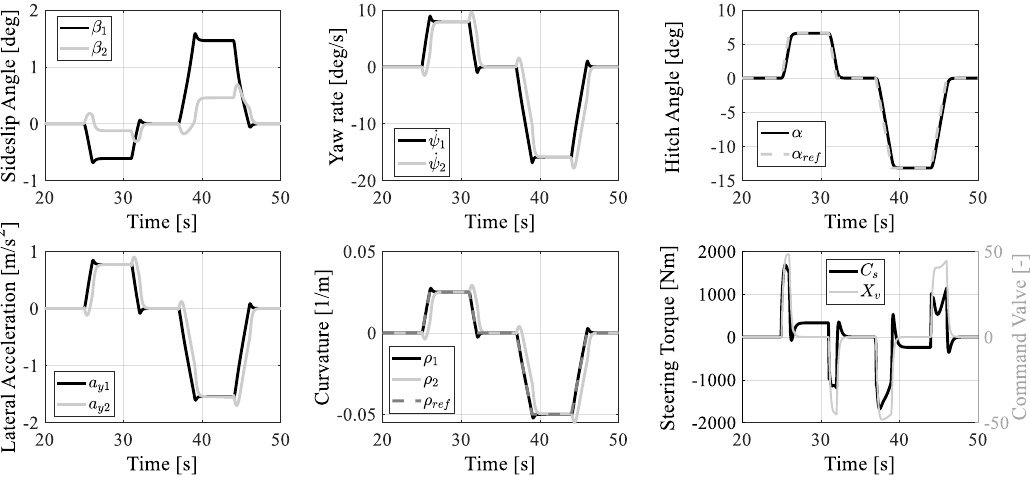
Figure 16. Sideslip angles, yaw rates, hitch angle, lateral accelerations, curvatures, steering torque, and hydraulic command valve during a multiple turn maneuver, with the hitch angle controller with SBL and fixed PID gains applied to the non-linear model at constant ATV speed 𝑢 1 = 20 km/h. Reprinted with permission from ref. [19]. Copyright 2020 Springer Nature Switzerland AG.